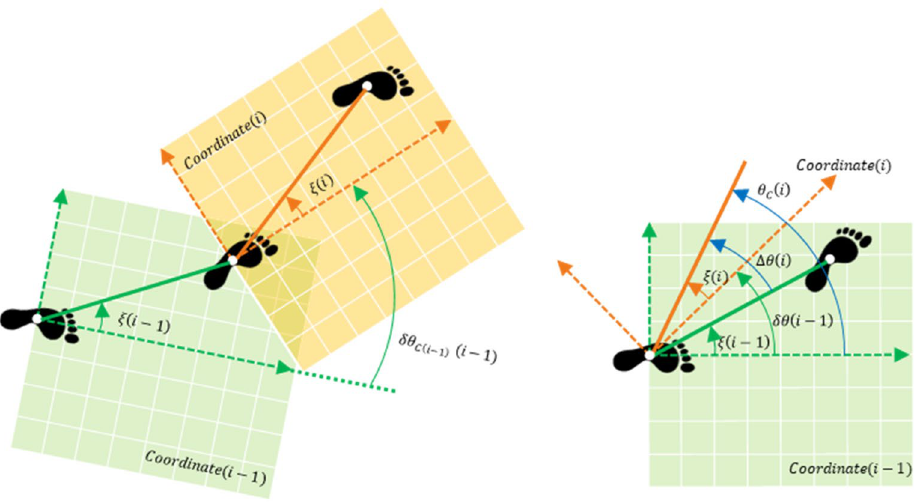
Figure 12. Relationship among local stepwise shank orientation ξ ( i ) , local stepwise stride vector angle δθ ( i ) , and local stepwise turning angle θ C ( i ) in horizontal plane for calculating continuous gait